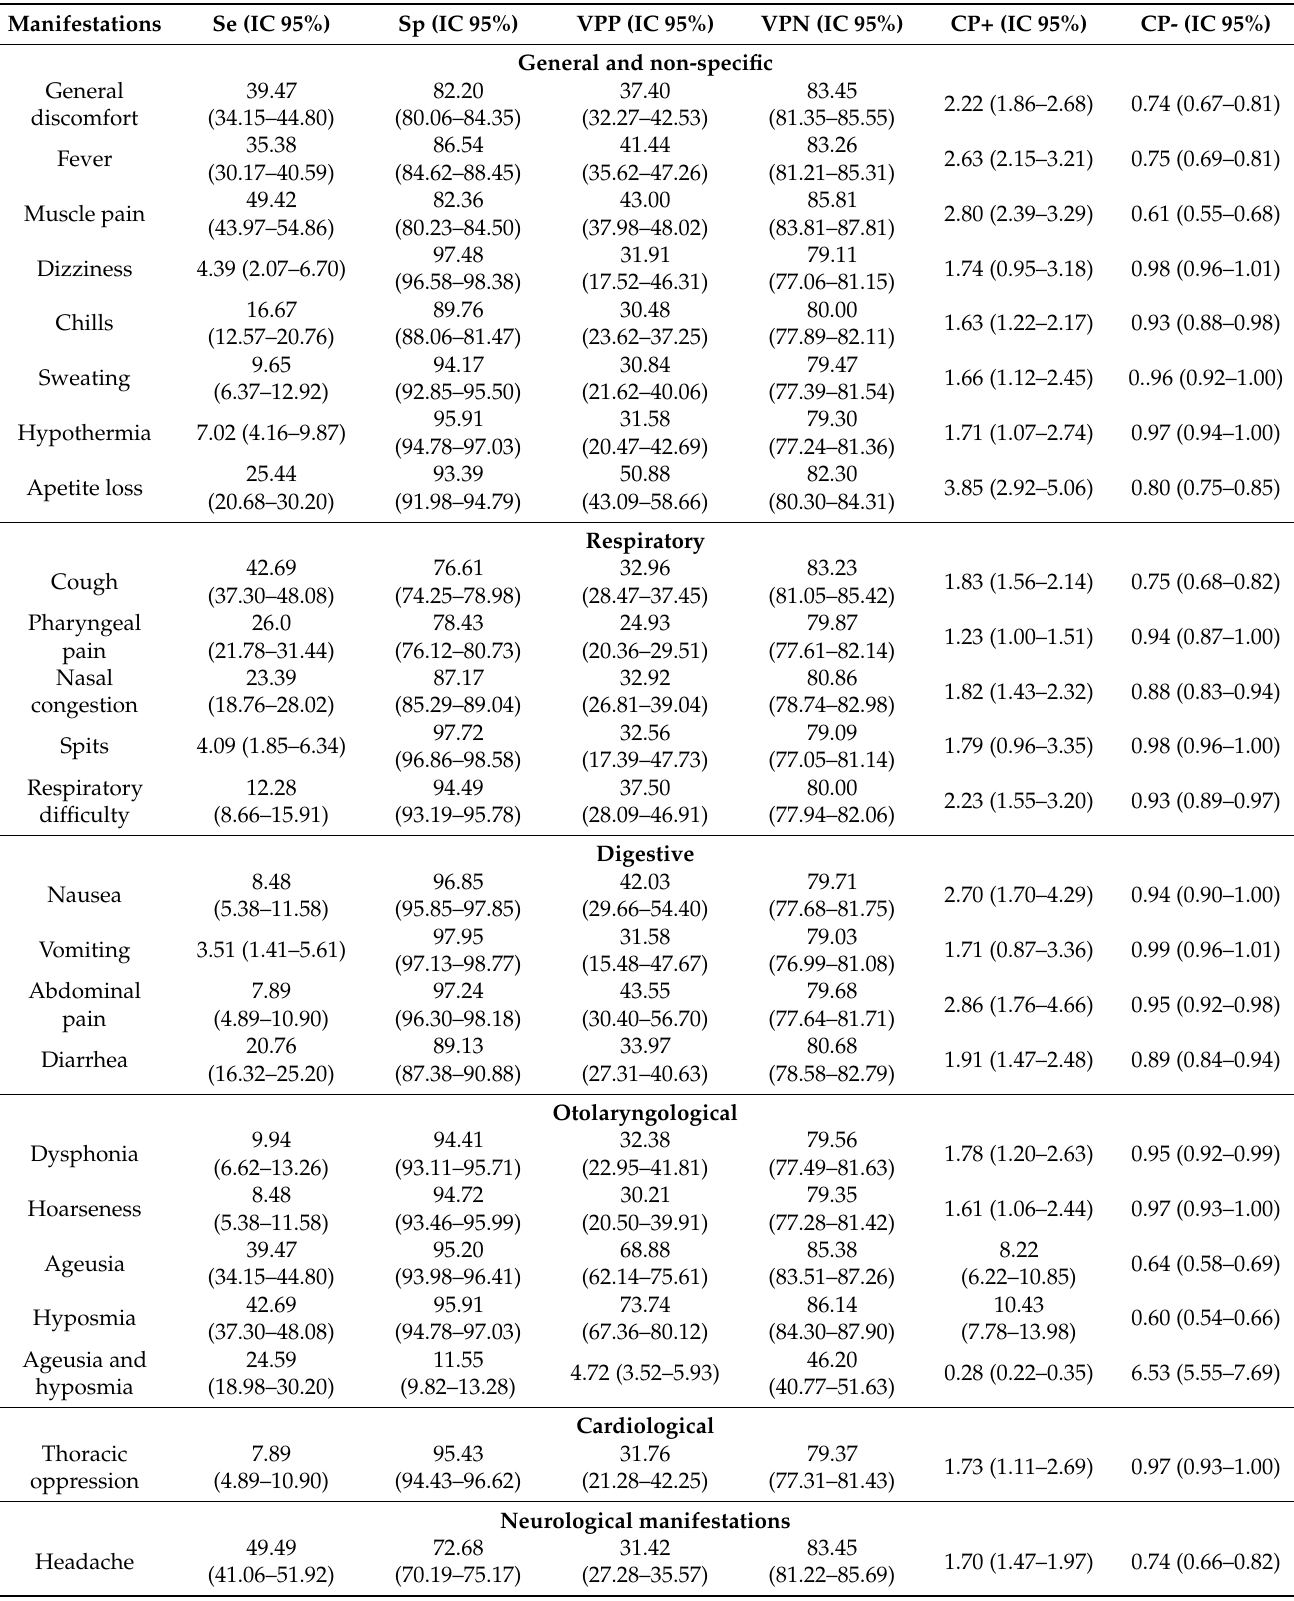
Table 5. Sensitivity, Specificity and Predictive Values of Symptoms Associated with SARS-CoV-2 Virus